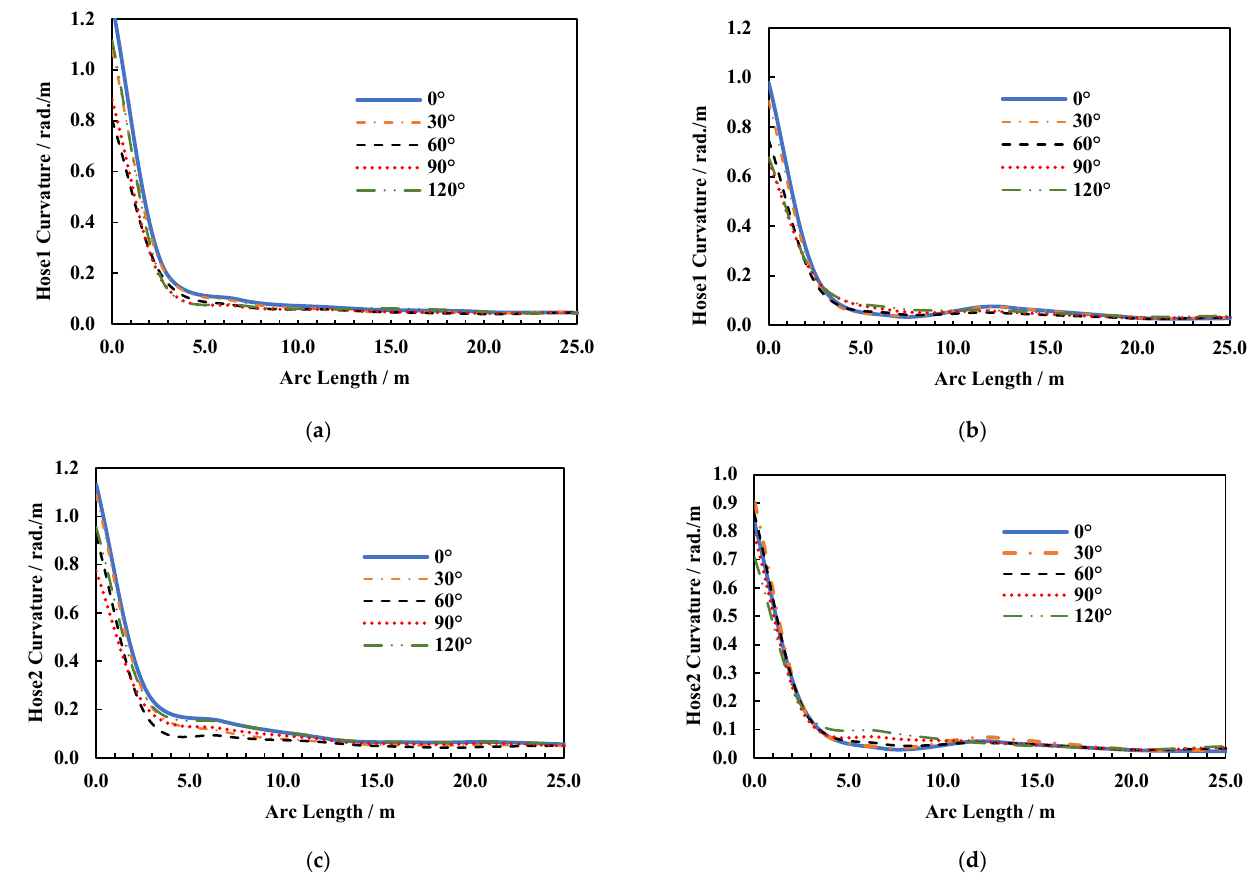
Figure 21. Influence of RAOs on curvature for different wave directions. Figures ( a , c ) are when the hoses have RAO loads, while Figures ( b , d ) are when the hoses are without RAO loads for the submarine hoses in Lazy-S config. ( a ) Hose1 Curvature including hose hydrodynamic load. ( b ) Hose1 Curvature excluding hose hydrodynamic load. ( c ) Hose2 Curvature including hose hydrodynamic load. ( d ) Hose2 Curvature excluding hose hydrodynamic load.